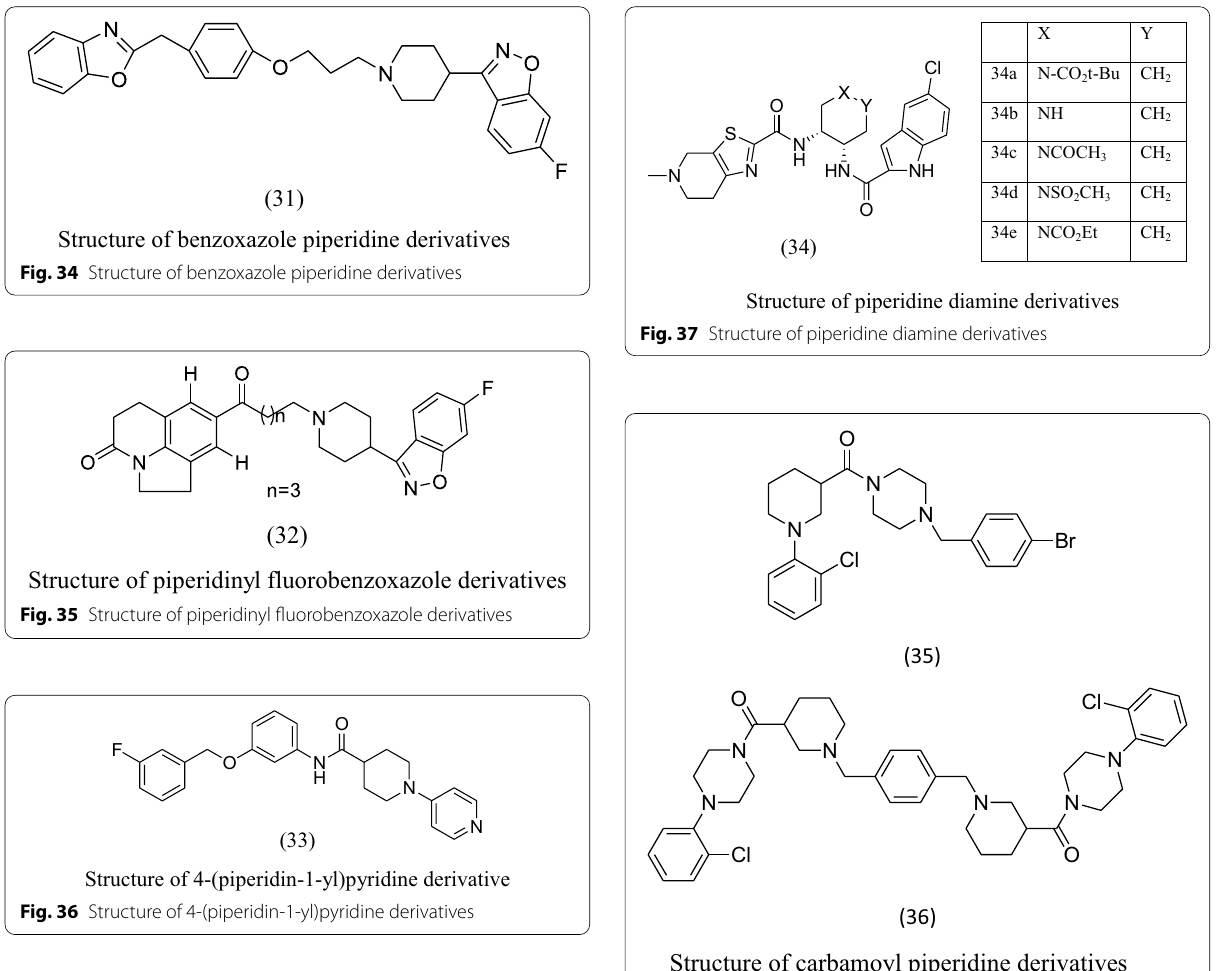
Fig. 38 Structure of carbamoyl piperidine